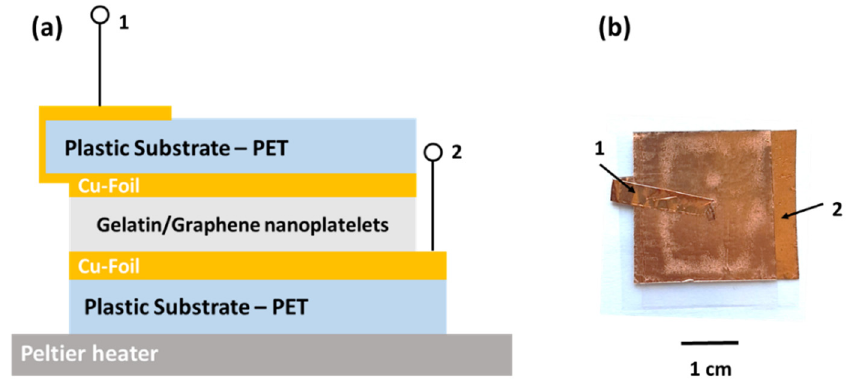
Figure 1. ( a ) Cross-section and ( b ) top view photograph of the symmetric device. The electrodes are indicated as (1) and (2).